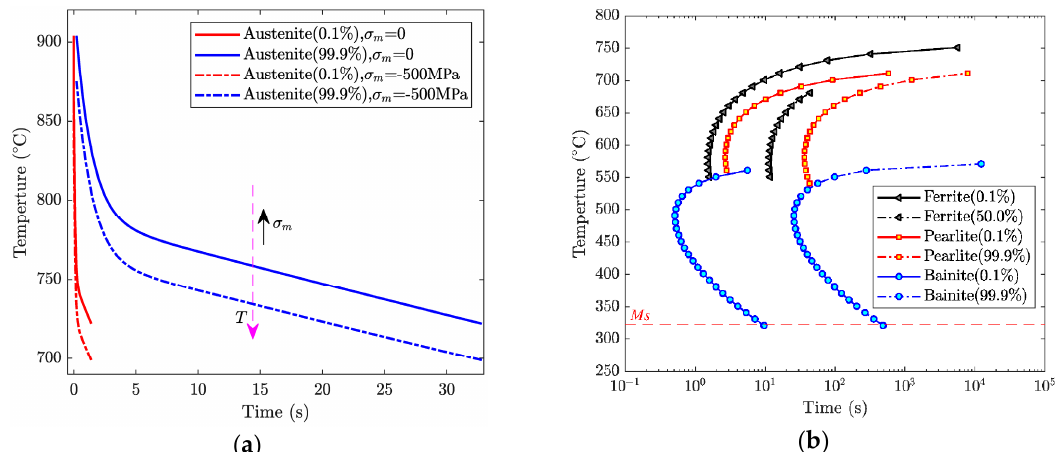
Figure 2. Transformation kinetic curves of AISI 1045 steel: ( a ) time–temperature-austenitization (TTA) diagram; ( b ) time–temperature-transformation (TTT) diagram.